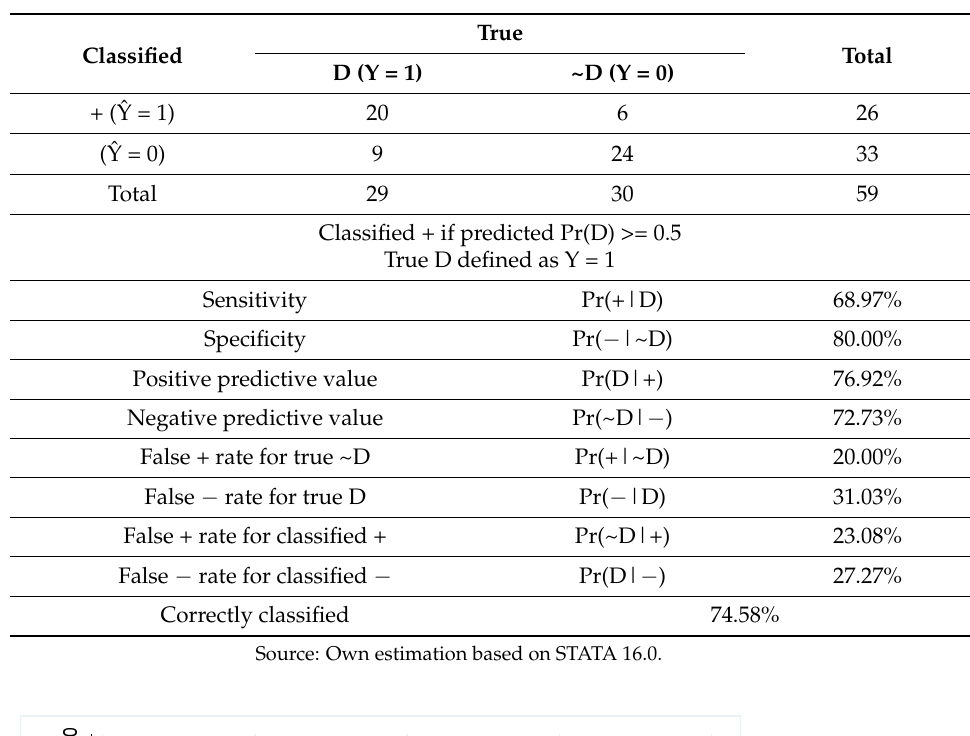
Table 5. Classification table for the model 6.